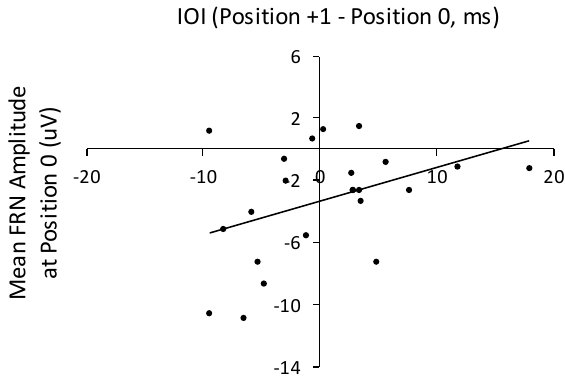
Figure 9. Correlation of mean IOI differences (target event position 1 minus position 0) from the three altered feedback conditions (future +1, future +2, and noncontextual) with mean FRN amplitudes elicited by altered feedback (target event position 0) across the three altered feedback conditions (future +1, future +2, and noncontextual). Each dot represents one participant.